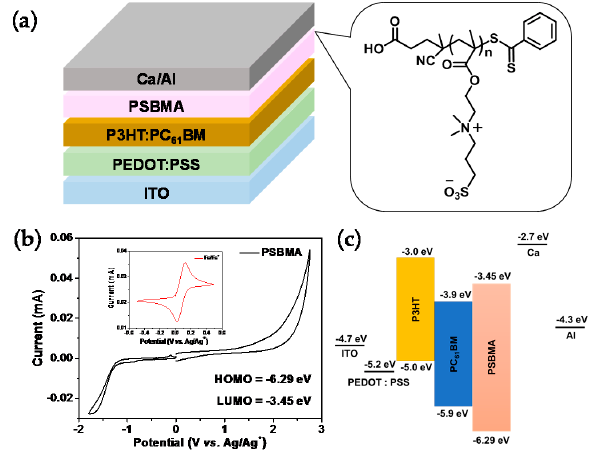
Figure 4. ( a ) Schematic illustration of the device structure of PSCs adopted in this study. ( b ) The cyclic voltammetry (CV) curve of PSBMA. ( c ) Energy level diagram of each component used in the PSCs.